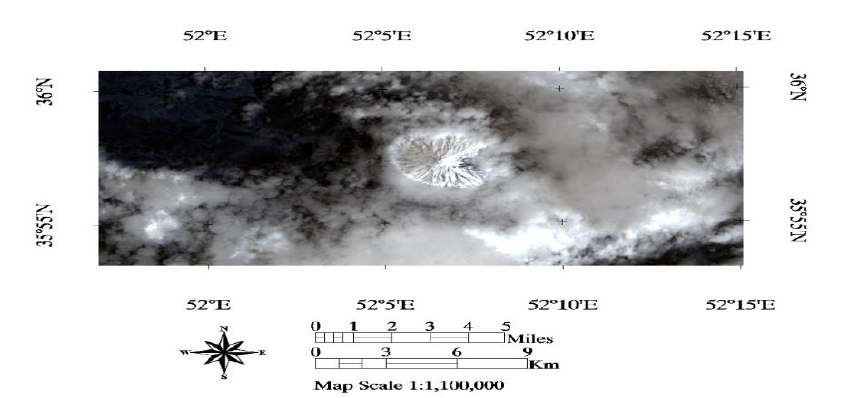
Fig.3: The selected case study